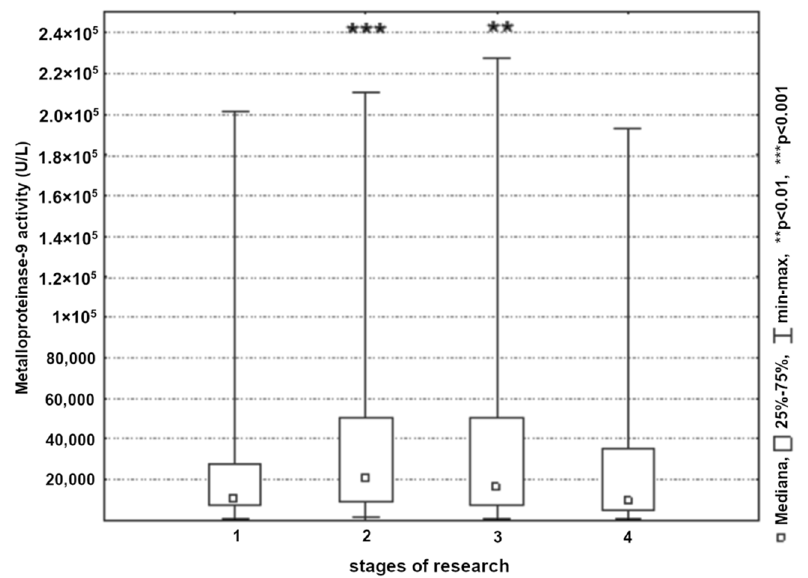
Figure 3. Metalloproteinase-9 activity in patients in the next stages of research (1, 24 h before surgery; 2, 8 h post-surgery; 3, 24 h post-surgery; and 4, 48 h post-surgery).